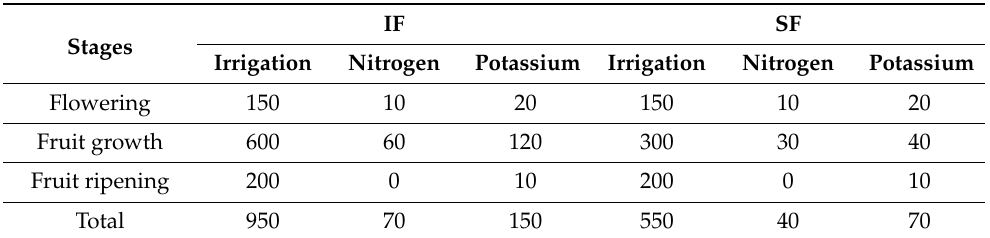
Table 1. Total irrigation (m 3 Ha − 1 ) and nitrogen/potassium fertilization (Kg Ha − 1 ) applied